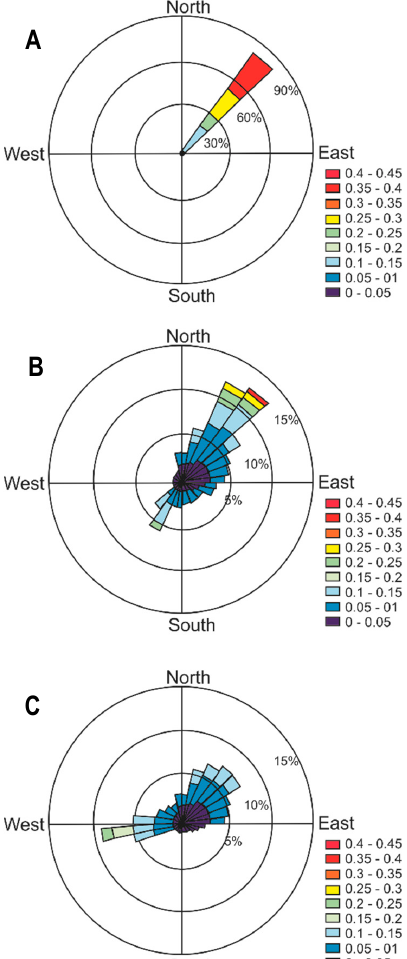
Figure 10. Mirim lagoon monthly frequency distribution of currents for ( A ) extreme north (transect T), ( B ) central (transect T2), and ( C ) extreme south (transect T1).